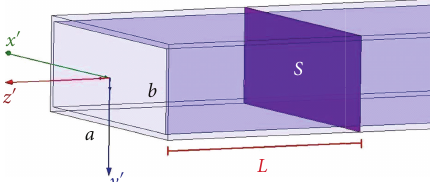
Figure 2: Truncated waveguide